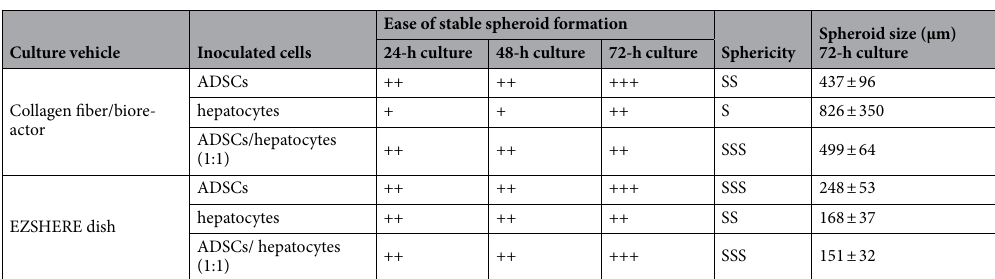
Table 1. Comparison of the spheroids generated from collagen fiber-based method and EZSHERE dish. + : ease, more + means more ease; × : cannot form; S: sphericity, more S means more sphericity.